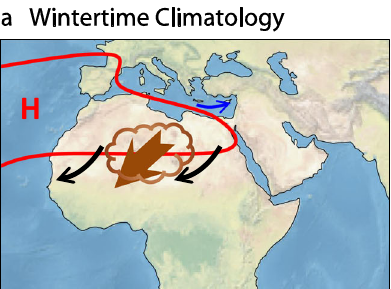
Fig. 3 | Schematic presentation of the stratospheric impacts on tropospheric circulation and North African dust. a The extended wintertime (from November to March, NDJFM) climatology of the tropospheric circulation and North African dust. b The same as panel a but for the sudden stratospheric warming (SSW) episodes. Various quantities used to illustrate the dust response include the sub- tropicalridge(redcontourline;seeSupplementaryFig.5foradescription),surface winds (black and blue arrows), dust emission (brown cloud-shaped pattern), and dust transport (brown arrows). As can be seen, during the extended winter season (NDJFM) (panel a ), the subtropical ridge tends to be located over northern Africa.